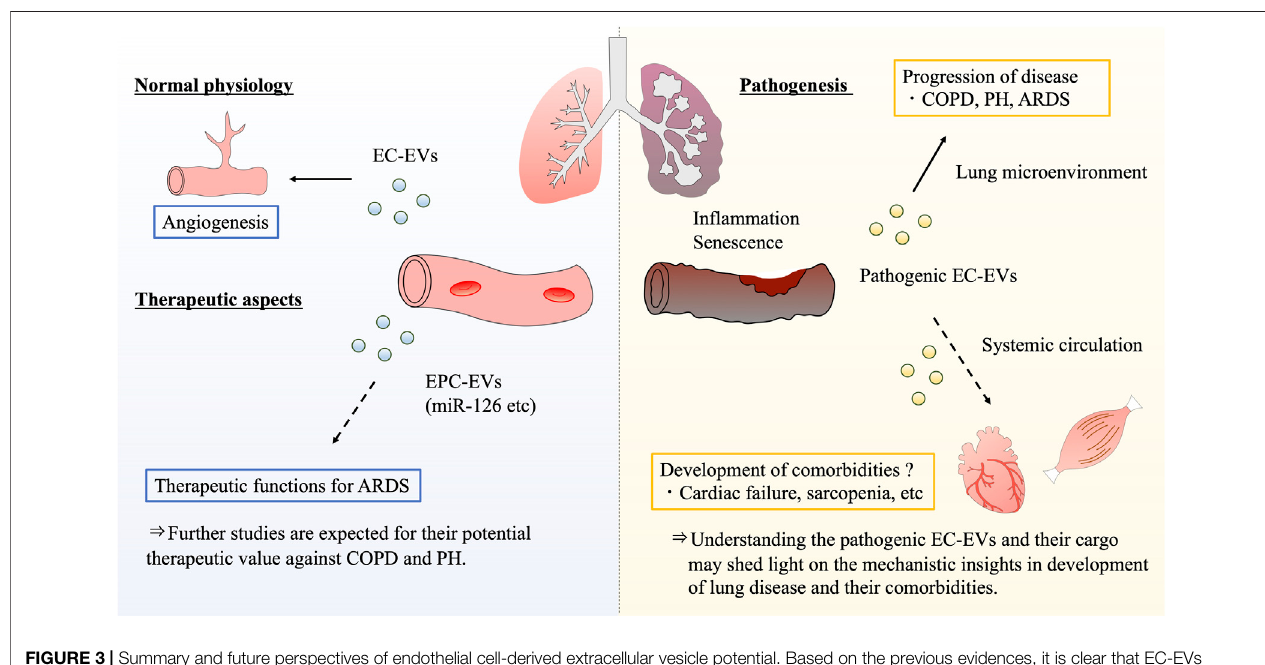
FIGURE 3 | Summary and future perspectives of endothelial cell-derived extracellular vesicle potential. Based on the previous evidences, it is clear that EC-EVs have the functions of regulating angiogenesis in normal endothelial physiology. With regard to therapeutic aspect, EPC-EVs may have the potential to be developed as novel treatments for various respiratory diseases. Recent studies indicate that EPC-EVs have therapeutic functions for ARDS through unique miRNA-related action mechanisms. On the other hand, pathogenic EC-EVs further promote in fl ammation and senescence phenotypes in the endothelial microenvironment, resulting in the progression of respiratory diseases such as COPD, PH, and ARDS. Notably, EC-EVs circulate throughout the body, the EVs exert in fl uences over various sites. As future perspectives, pathogenic EC-EVs can form the respiratory disease pathogenesis, and are expected to be involved in the development of their comorbidities. COPD: chronic obstructive pulmonary disease, PH: pulmonary hypertension, ARDS: acute respiratory distress syndrome, EC: endothelial cell, EPC: endothelial progenitor cell, EV: extracellular